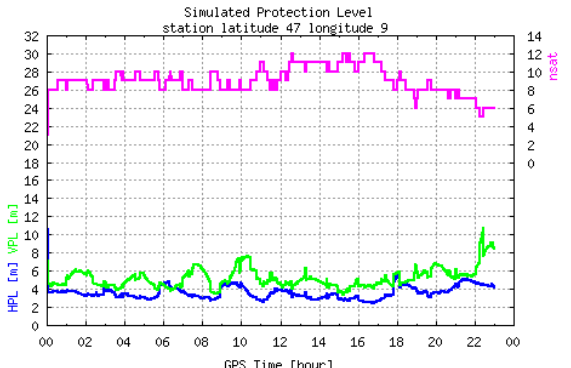
Figure 11. Ionospheric part of the vertical and horizontal Protection Level with the number of satellites. The simulated site is in Zurich on 20/08/2018.